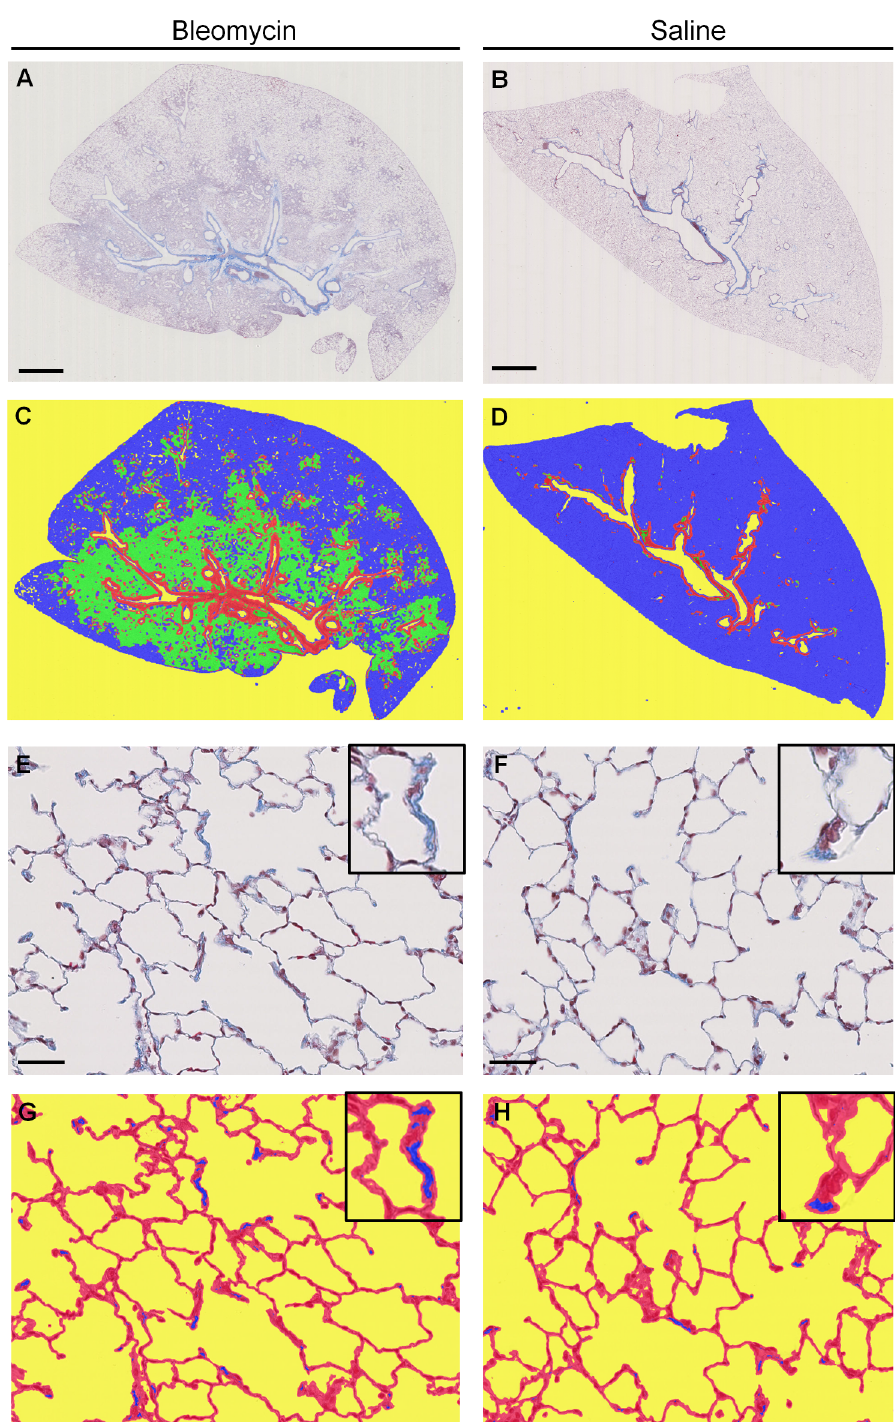
Fig 2. Fibrosis feature detection. Masson’s trichrome stained lung sections from study 3, Bleomycin (A, C, E, F) and Saline (B, D, F, H) animals, A and B at low magnification, scale bar 2.5mm E and F alveolar structure at high magnification, scale bar 50μm. Upper right square: zoom in one alveola. C and D : low scale detection model; false colour image indicates areas of dense fibrosis (green), alveolar tissue (blue), bronchi (red), background (yellow). G and H: high magnification detection; false colour image indicates collagen (blue), lung tissue (red), background (yellow). Upper right square: zoom in one alveola collagen detection.